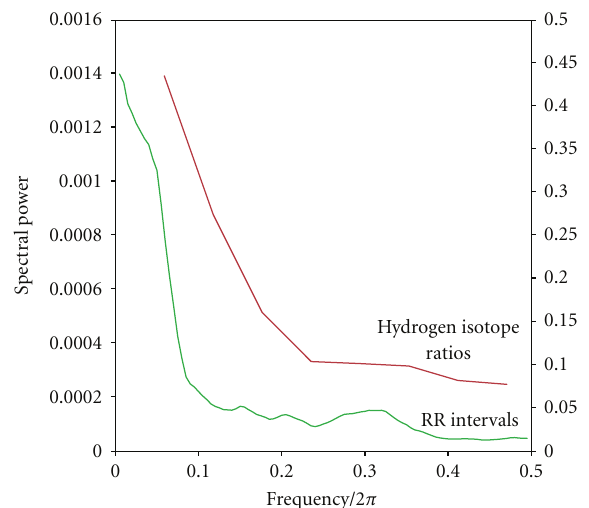
Figure 6: Comparison of power spectra derived from hydrogen isotope ratios along the length of the hairs and power spectra derived from heart rate intervals (RR) in the same subjects. Note that the low- and high-frequency power bands are of comparable lengths but the spectral power appears di ff erent (NS) (“stacked” averaged spectra from all subjects). Red line hydrogen isotope ratios; green line heart rate variability (RR intervals). Spectral power, on the y -axis, is hydrogen isotope ratios (right) and RR intervals